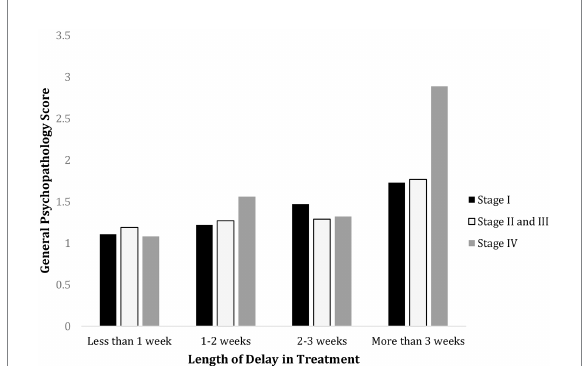
FIGURE 1 Psychological effect of treatment delay on breast cancer patients